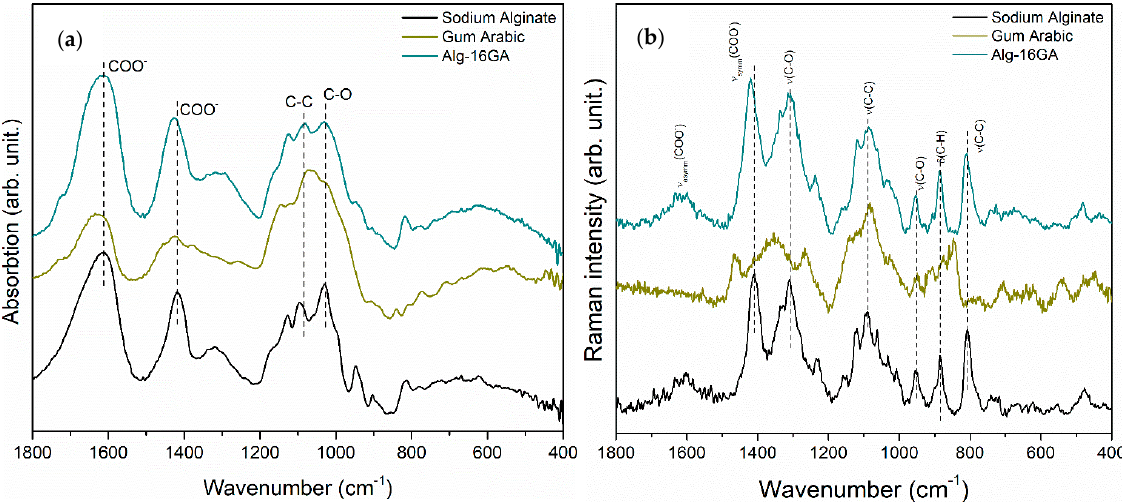
Figure 1. FT-IR ( a ) and Raman spectra ( b ) of pure sodium alginate (black line), pure gum arabic (yellow line), and cross-linked Alg-16GA composite (green line).